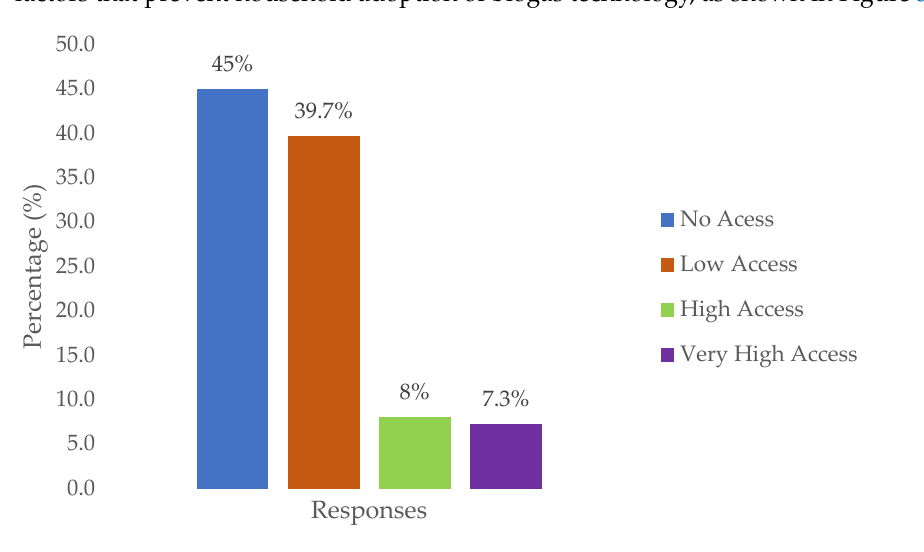
Figure 3. Access to biogas knowledge and technical expertise.